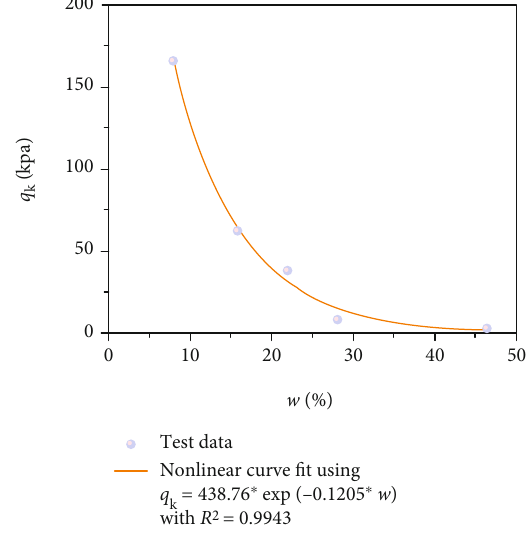
Figure 7: Relation between structural strength and moisture content for undisturbed